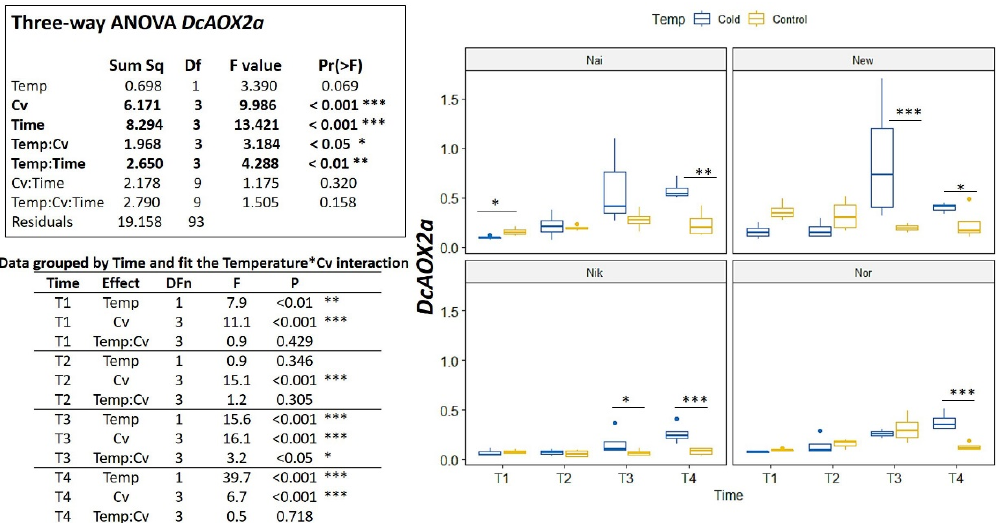
Figure 6. Expression box-plot and three-way ANOVA analysis for DcAOX2a during cold challenge (T1: 4 h, T2: 8 h, T3: 24 h and T4: 7 days), in carrot cultivars (Cv) ’Nairobi’ (Nai), ‘Newcastle’ (New) ‘Nikki’ (Nik), and ‘Norwich’ (Nor) eight weeks after sowing. Transcript levels were determined by RT-qPCR. For each time point, 10–12 biological replicates were considered per temperature. Significant differences between temperatures for the same time point are indicated by * ( p < 0.05), ** ( p < 0.01) or *** ( p < 0.001). Boxplots show the distributions (median, spread and outliers) of the gene expression values.